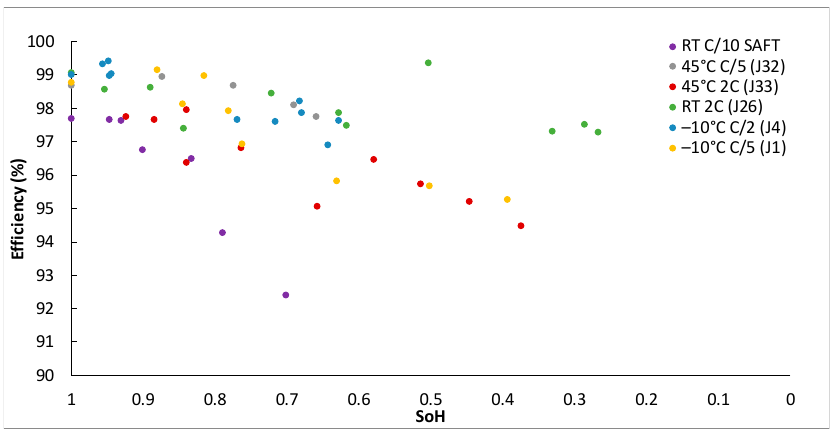
Figure 6. Evolution of the efficiency of the cells in relation to SoH.